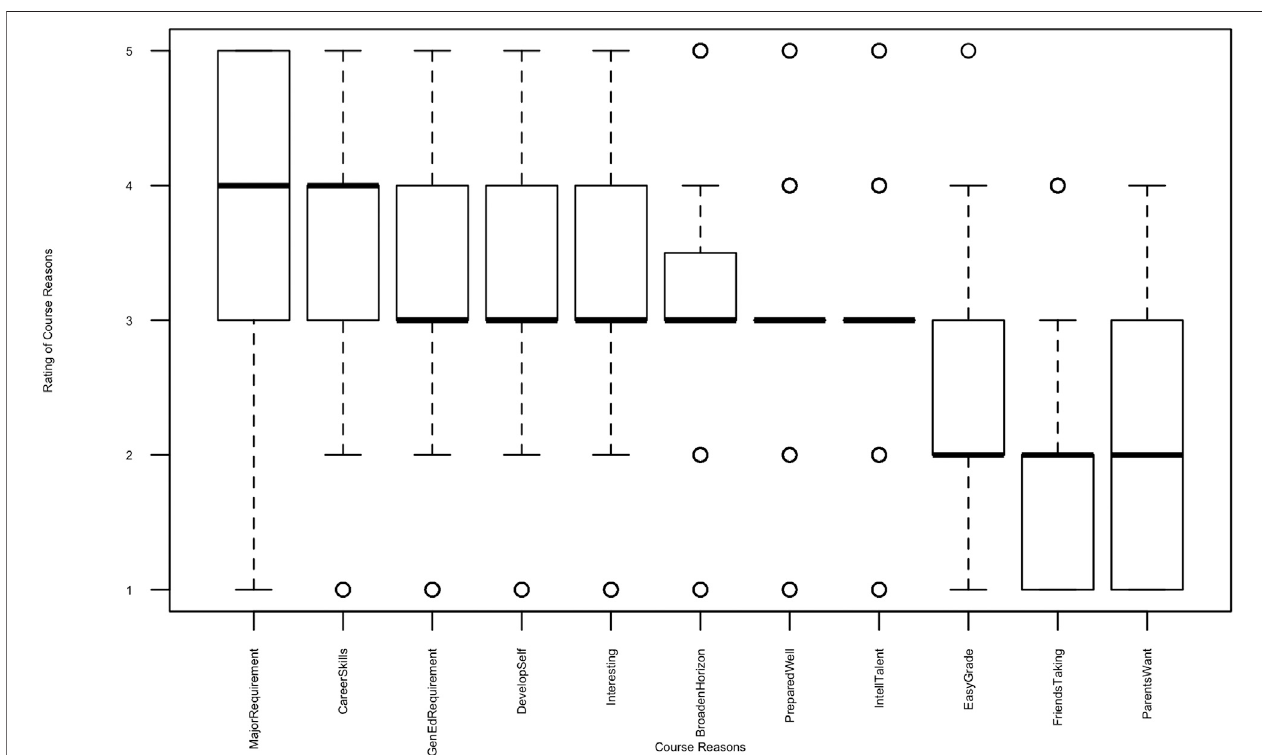
FIGURE1| Boxplotofcoursechoicereasons.1 (cid:1) theleastimportantreasonchoice,2 (cid:1) thesecondand thirdleastimportant reasonchoices, 3 (cid:1) nottheleastnor most important reason choice, 4 (cid:1) the second and third most important reason choice, 5 (cid:1) the most important reason